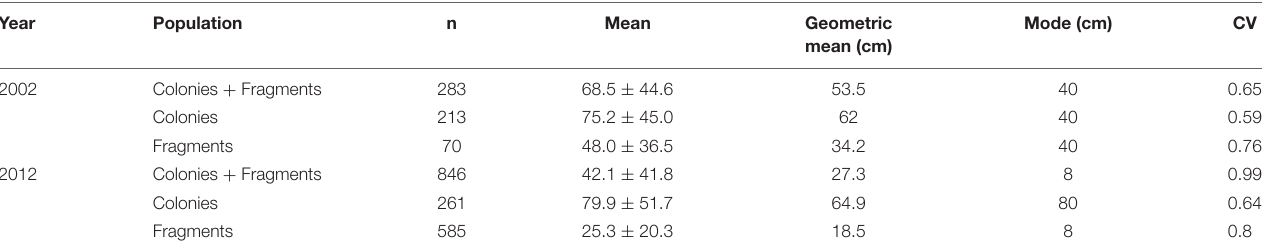
TABLE 1 | Temporal comparison of the average size of colonies and fragments comprising the population of Dendrogyra cylindrus , measured as height of colonies and length of fragments in 2002 and 2012.